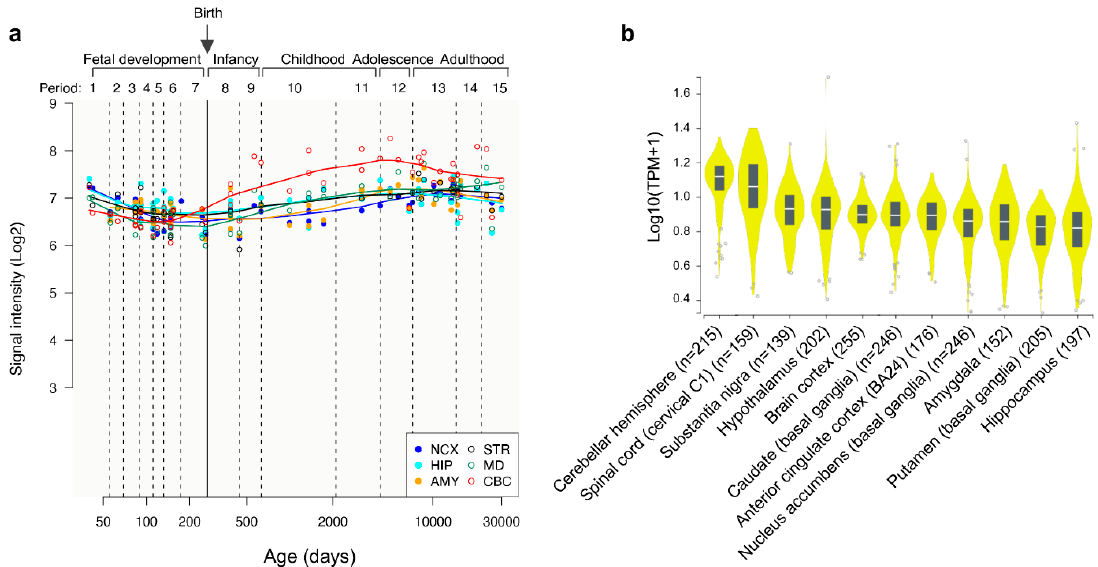
Figure 1. Temporospatial WWOX expression in human CNS tissues. ( a ) Trajectory plot showing the expression of WWOX during fetal development (period 1–7), infancy (period 8–9), childhood (period 10–11), adolescence (period 12), and adulthood (period 13–15), in individual CNS areas: neocortex (NCX), hippocampus (HIP), amygdala region (AMY), striatum (STR), mediodorsal nucleus of the thalamus (MD), and cerebellar cortex (CBC). Reprinted and adapted from Human Brain Transcriptome dataset (https://hbatlas.org/) [17]. ( b ) Violin plots showing the expression of WWOX in different brain regions as per the Genotype-Tissue Expression dataset (GTEx, Analysis Release V8, dbGaP Accession phs000424.v8.p2). Horizontal line in black box indicates the median value of WWOX expression in respective tissues; the number of samples for each tissue is indicated in the X-axis legend. TPM: Transcripts per Million. Reprinted and adapted from the RNA-seq GTEx database (https://gtexportal.org) [18].